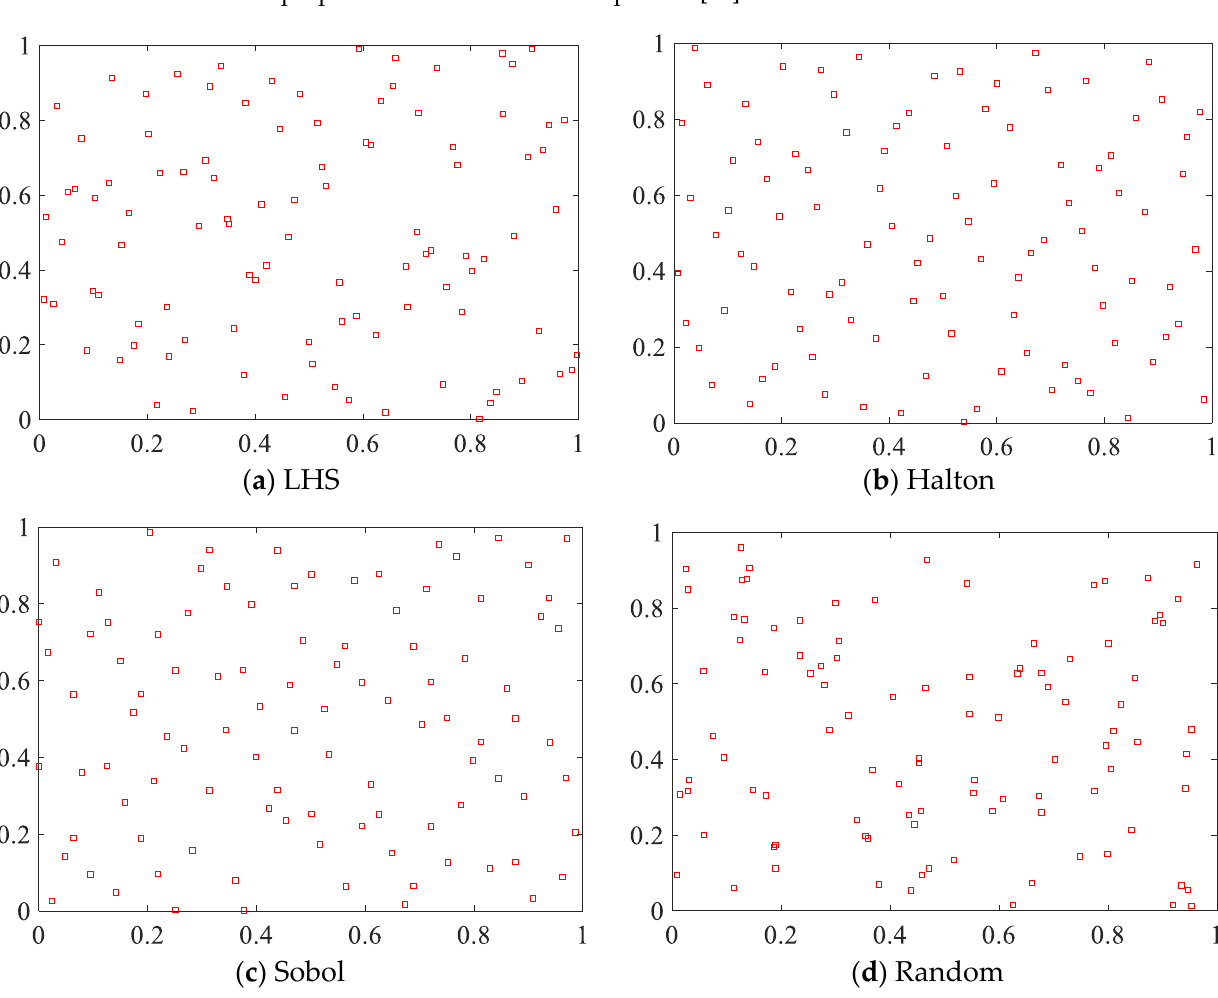
Figure 2. Two – dimensional scatter plots of different sequences. ( a ) LHS sequence; ( b ) Halton se- quence; ( c ) Sobol sequence. ( d ) Random sequence. sequence; ( c ) Sobol sequence. ( d ) Random